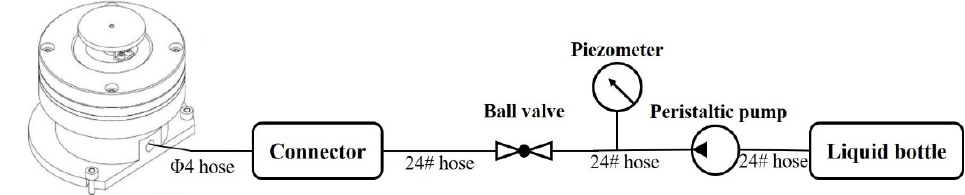
Figure 9. Diagram of the stiffness testing system.